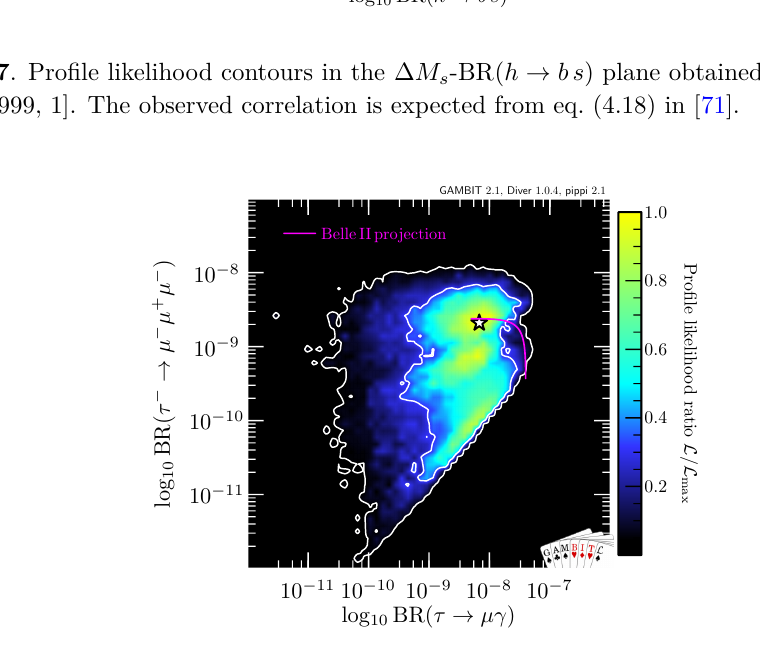
Figure 18 . BR( τ → 3 µ ) versus BR( τ → µγ ) . The magenta solid line is the combined Belle II experiment future sensitivity obtained for both observables using a one-sided Gaussian upper limit likelihood function at 90 %